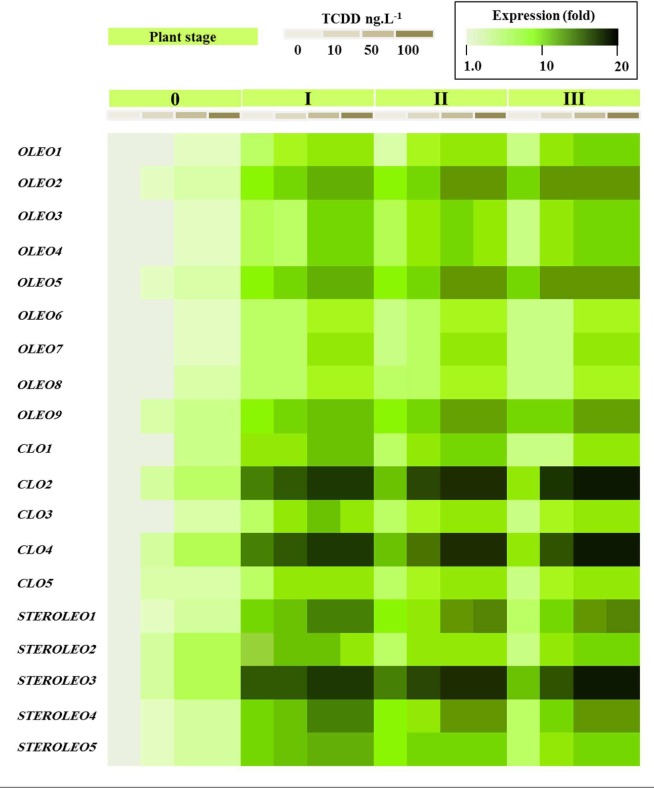
Transcriptional analysis of the relative expression levels of oleosin, caleosin and steroleosins encoding genes (OLEO, COL, and STEROLEO) in whole date palm seedlings after exposure to TCDD (0, 10, 50, and 100 ng L-1). For each gene, the transcript level was evaluated by qRT-PCR as described in Section “Materials and Methods.” Three measurements were taken in three cDNAs prepared from three individual plants for each treatment. The color scale (white-green-black) indicates relative changes of transcript abundance of 1, 10, and 20 fold, respectively. For each gene, the expression levels in seeds and seedlings of date palm unexposed to TCDD were defined as 1, and the corresponding abundance changes under 10, 50, and 100 ng L-1 TCDD were calculated directly using the software installed in the Applied Biosystems qPCR system.